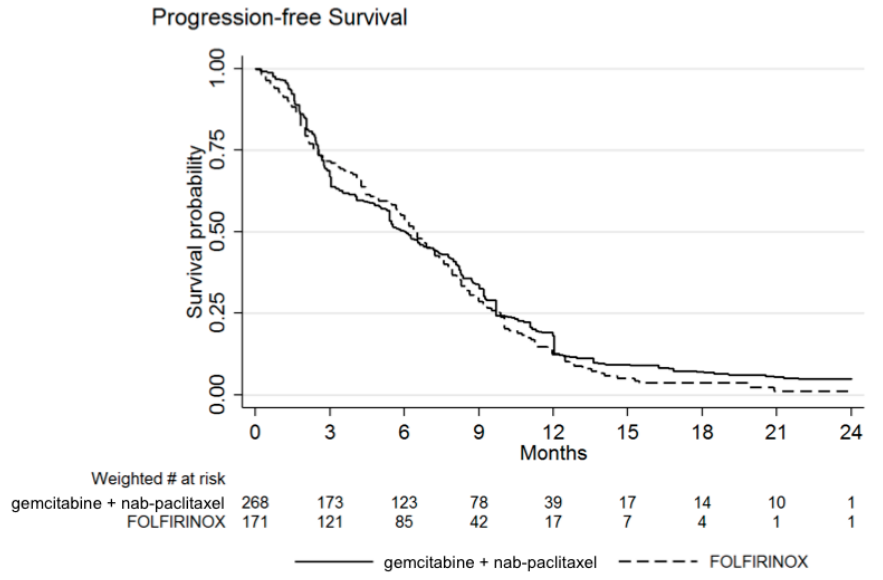
Figure 2. Weighted Kaplan–Meier estimates of progression-free survival (PFS). PFS was 6.4 months with FOLFIRINOX and 6.0 months with gemcitabine + nab-paclitaxel. Hazard ratio of FOLFIRINOX over gemcitabine + nab-paclitaxel was 1.11 (95% CI 0.82–1.50; p = 0.520).